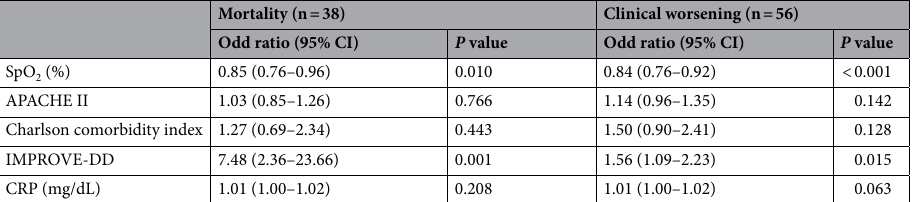
Table 4. Multivariate analysis for in-hospital mortality and clinical worsening. APACHE II acute physiology and chronic health evaluation II, CI confidence interval, CRP C-reactive protein, DD D-dimer, IMPROVE international medical prevention registry on venous thromboembolism, SpO 2 peripheral oxygen